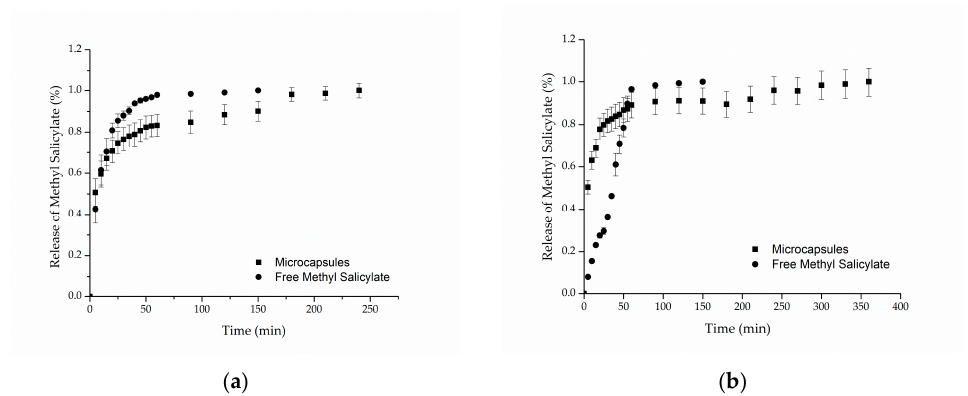
Figure 5. In vitro release profile of methyl salicylate from ( a ) cotton and ( b ) polyamide textile.